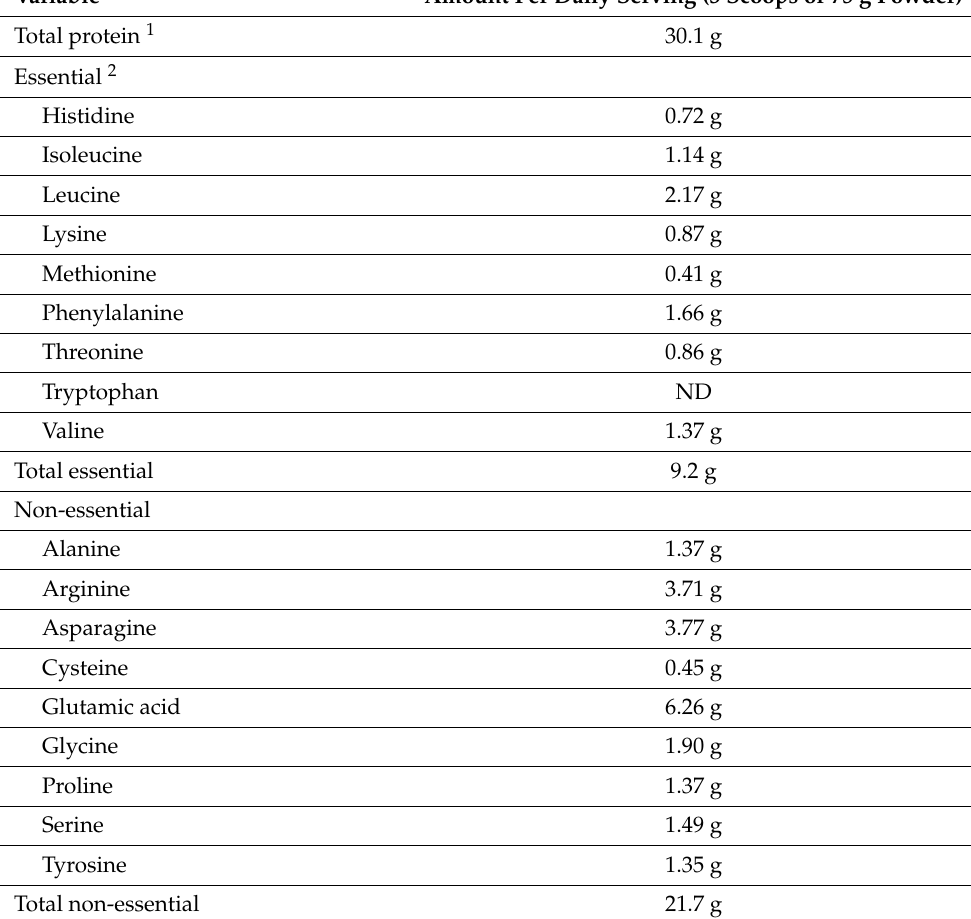
Table 1. Amino acid content in PP per daily